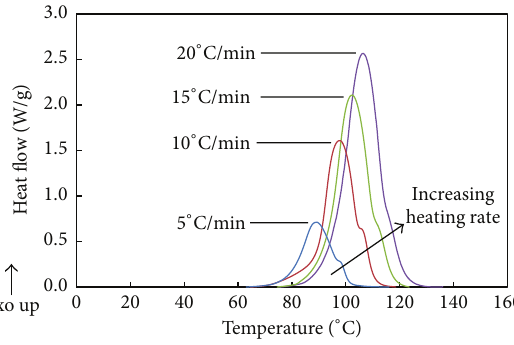
Figure 2: DSC exothermic curves of